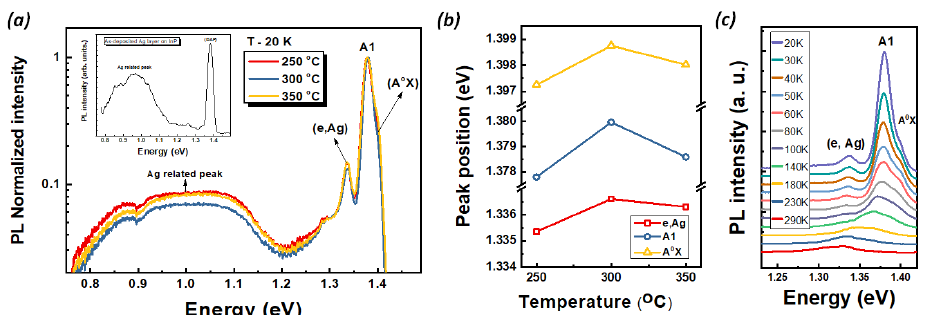
Figure 2. ( a ) PL spectra of the as-deposited Ag layer on InZnP(inset) and InZnP:Ag nano-rod samples annealed at 250, 300, and 350 ◦ C measured at 20 K. ( b ) The peak position of (A 0 X), A1, and (e, Ag) as a function of the annealing temperature of the InZnP:Ag nano-rods measured at 20 K. ( c ) The temperature-dependent PL spectra of InZnP:Ag nano-rod samples annealed at 300 ◦